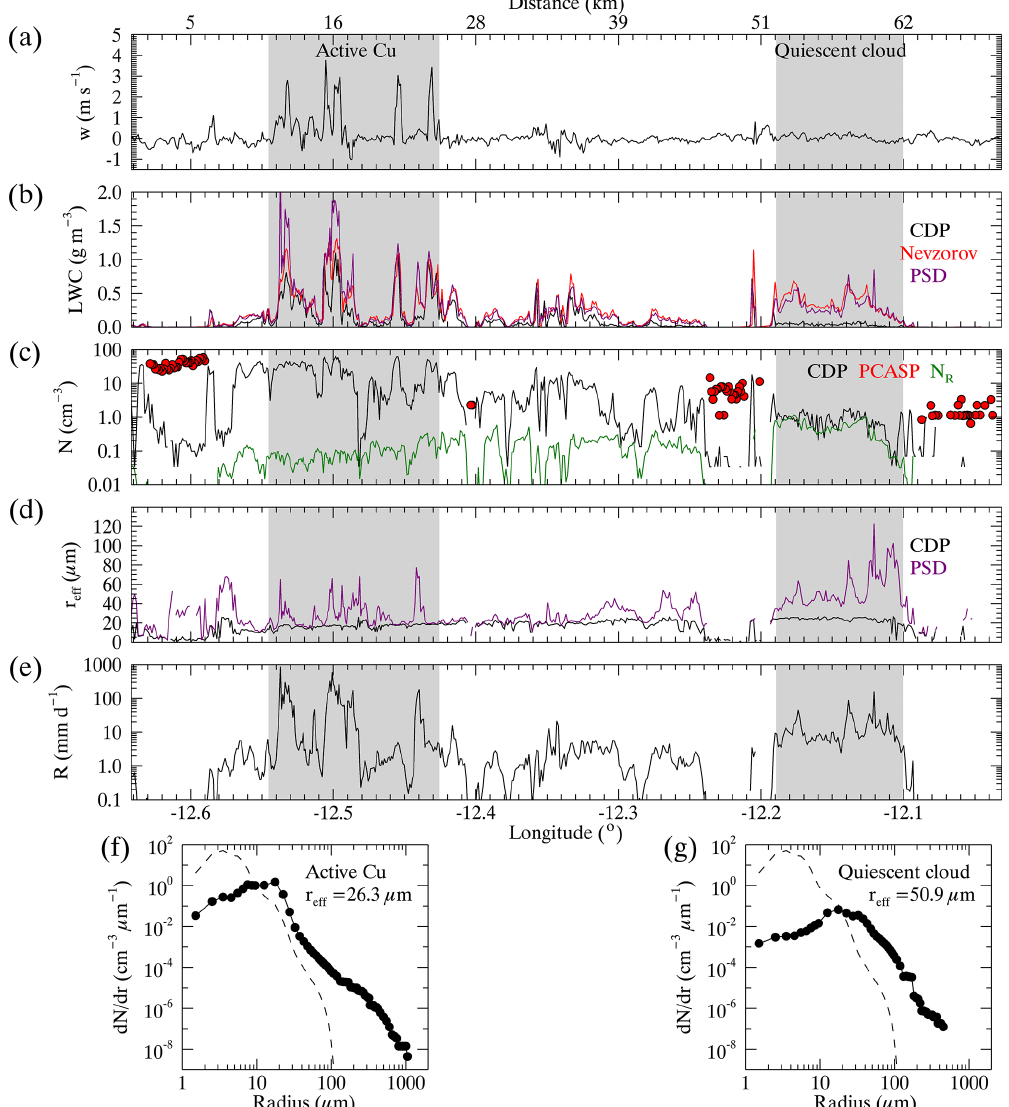
Figure 12. Aircraft observations from run R1 on flight C052 at 1320m altitude covering a distance of ∼ 70km. The panels show (a) vertical velocity; (b) liquid water content calculated from the CDP, Nevzorov TWC sensor and integrating the composite particle size distribu- tion; (c) number concentration of cloud drops (CDP), rain drops ( N R ) and out-of-cloud accumulation-mode aerosol number concentration (PCASP); (d) the effective radius calculated from the CDP and the composite PSD; (e) precipitation rate from the composite PSD. Panels (f, g) contrast the mean size distributions averaged over an active Cu cell and a more quiescent cloud at the times indicated by the grey shading. The mean in-cloud size distribution from flight C051 is shown with a dashed line for